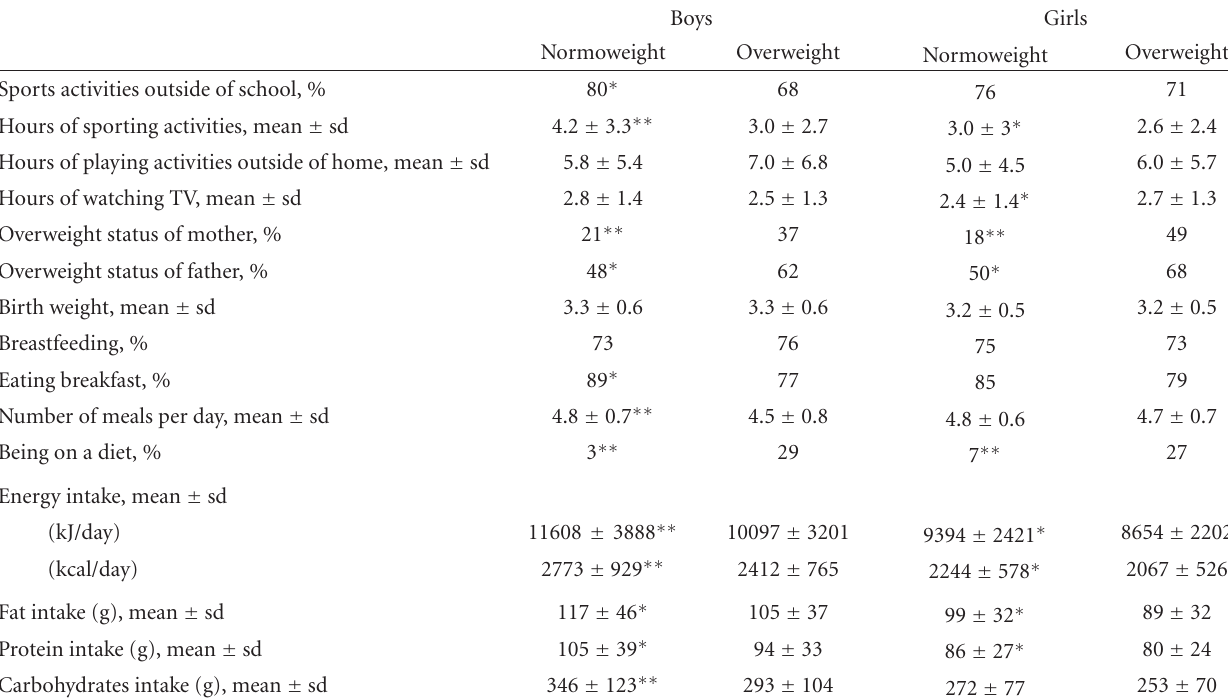
Table 2: Variables investigated in relation to weight status.